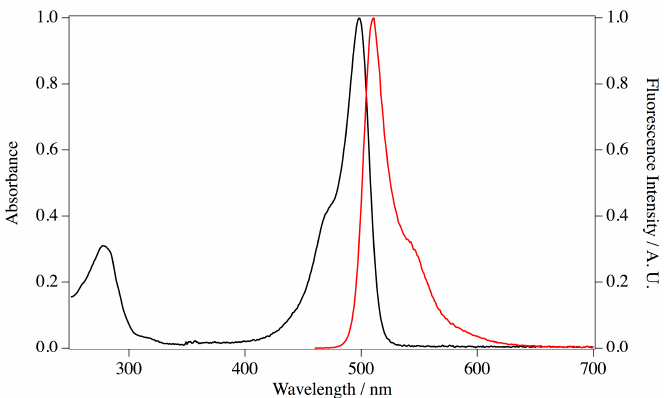
Figure 6. Absorption (black line) and fluorescence emission (excitation at 450 nm, red line) spectrum of ScSuFP at pH 7.0. Absorption maximum is at 498 nm and emission maximum is at 511 nm. Absorbance and fluorescence intensity are normalized at 498 nm and 511 nm, respectively.